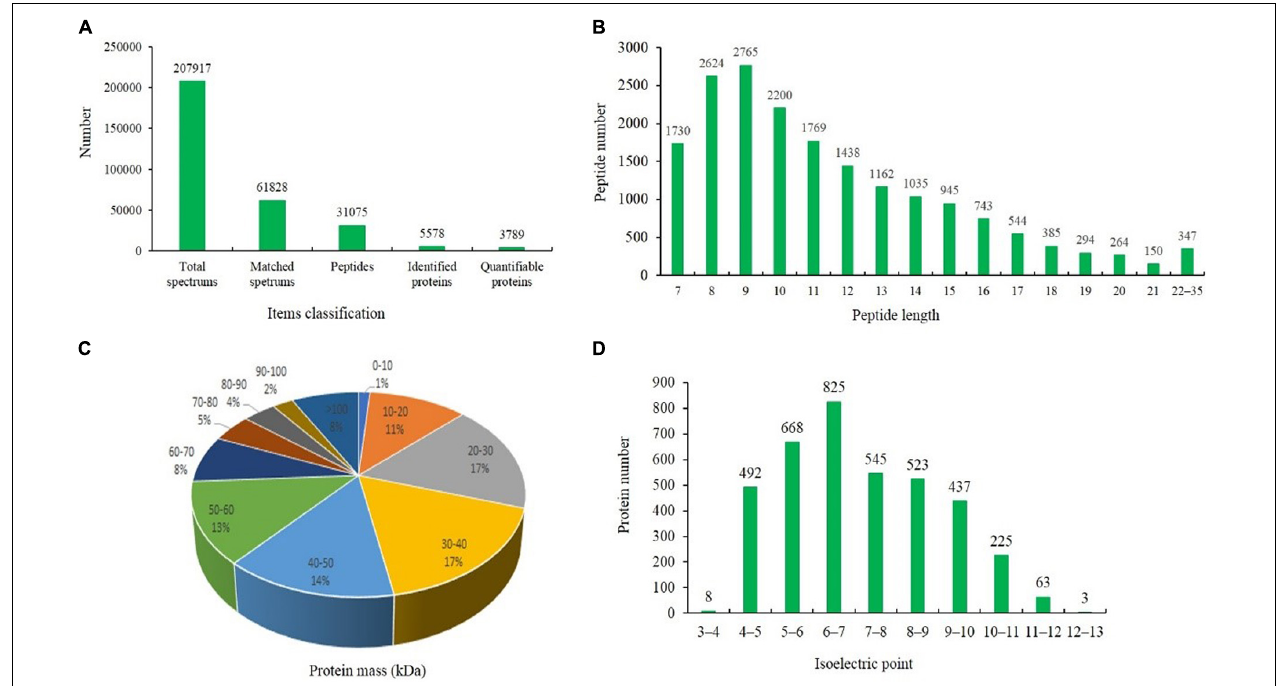
FIGURE 3 | Results of the tandem mass tag (TMT)-based liquid chromatography-tandem mass spectrometry (LC-MS/MS) identification of the leaves of the grapevine rootstock. (A) Classification of the items used for identifying proteins. (B) Number and length of the identified peptides. (C) Distribution of the average molecular masses of identified proteins. (D) Distribution of the isoelectric points of the identified proteins.